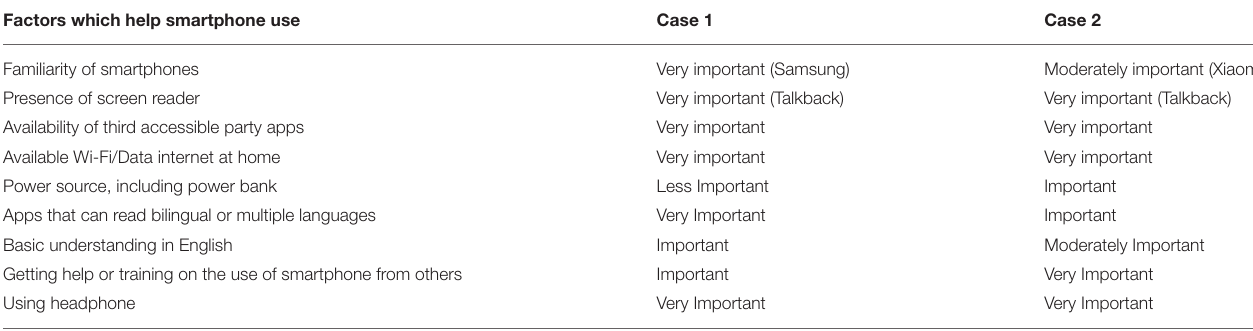
TABLE 2 | Enabling factors for smartphone use among people with profound visual impairment.